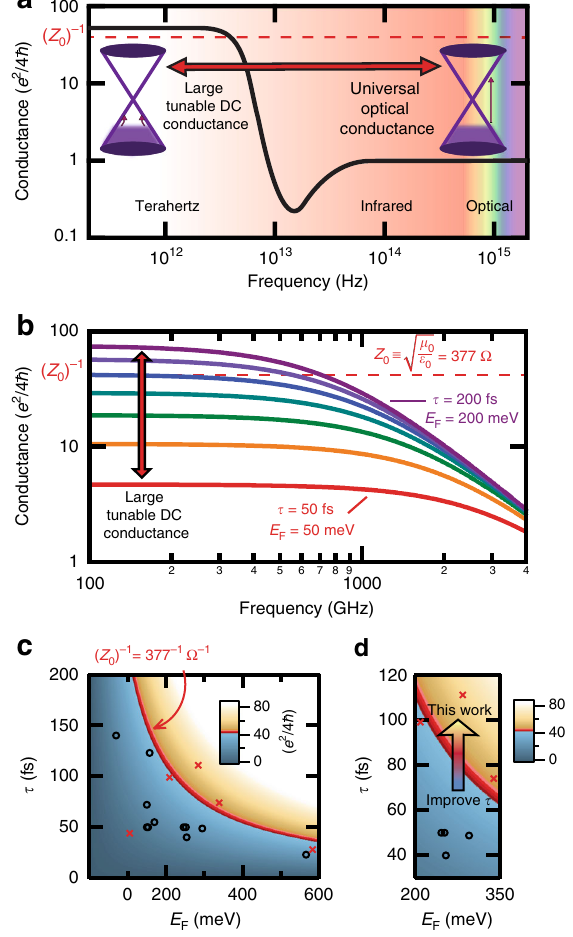
Fig. 1 THz conductance. a Qualitative trend of frequency-dependent AC conductance for monolayer graphene with normalization to e 2 /4 ħ . The optical frequency range exhibits a universal value of 1, while in the THz range, the AC conductance can be orders of magnitude higher. b Theoretical trend of THz AC conductance for monolayer graphene plotted with a linear variation of the E F , and τ . Graphene samples can cross the free space conductance value, ( Z 0 ) − 1 , within the THz regime. c Device design plot showing the graphene sheet conductance (at 100 GHz) in units of ( e 2 /4 ħ ) for changes in E F and τ . The ( Z 0 ) − 1 threshold is set as red on the color scale. Previous graphene THz device parameters are plotted as circles, whereas those from this work are denoted as x ’ s. d By